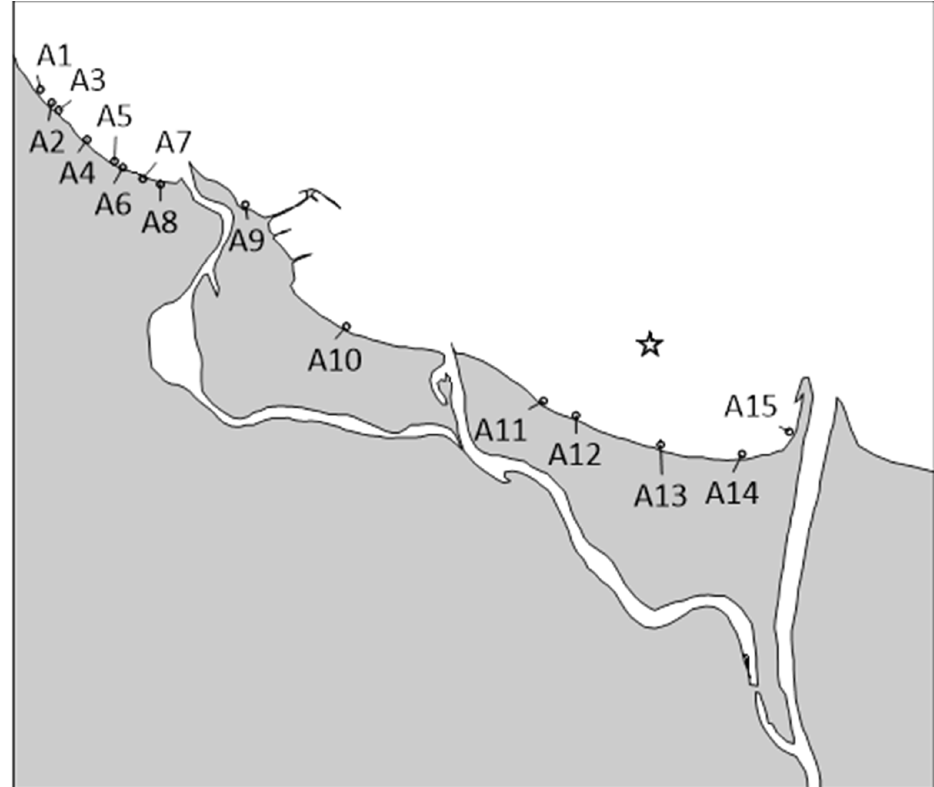
Figure 4. Location of bathing water sampling sites (A1–A15) with pipe outlet from the Gda´nsk Wschód WWTP (star).